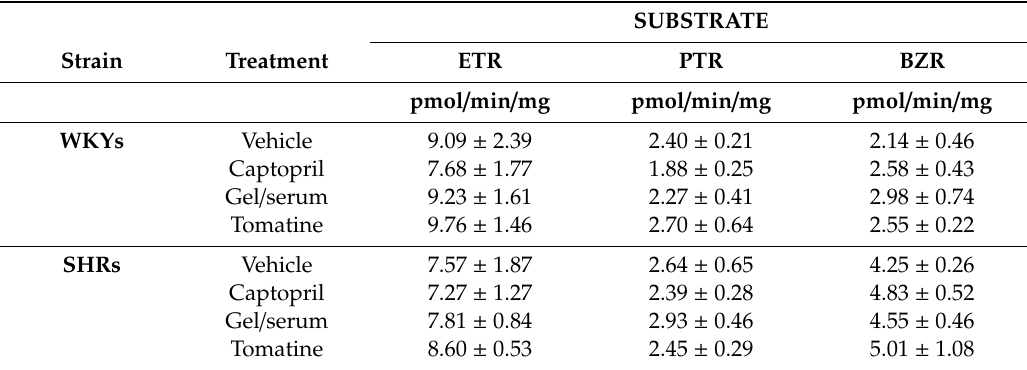
Table 6. Cytochrome P450-dependent monooxygenase activities in liver microsomes from treated WKYs and